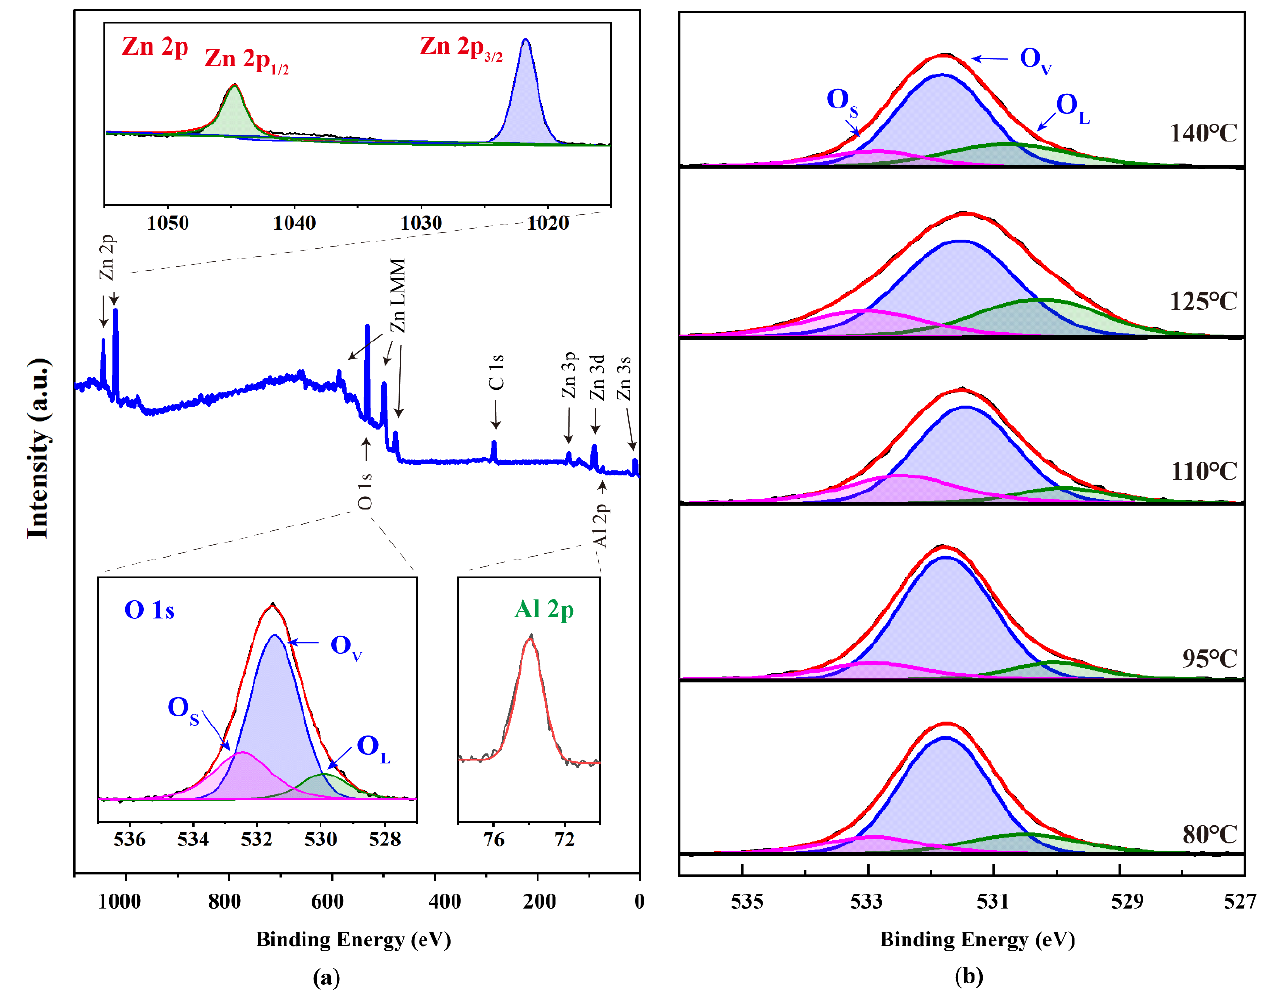
Figure 3. ( a ) XPS spectrum of supported ZnO nanosheet arrays grown at 110 °C. Major spectral lines and auger lines are labelled. The inset is the narrow scan corresponding to Zn 2p, O 1s, and Al 2p ( b ) Variations in O 1s narrow scan with different hydrothermal temperatures.